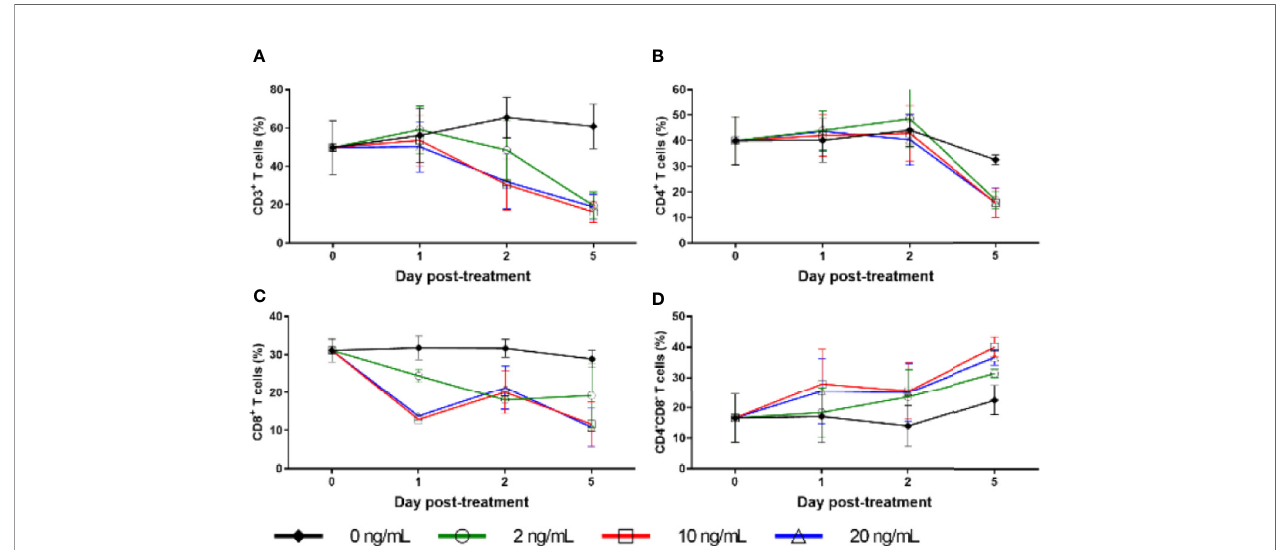
FIGURE 8 | Cell surface marker expression with RMD treatment in vitro . Percentage of freshly separated PBMCs expressing CD3 (A) , CD4 (B) , and CD8 (C) , and CD4 − CD8 − double negative PBMCs (D) treated with increasing RMD doses of (0, 2, 10, and 20 ng/ml); animal number: n =